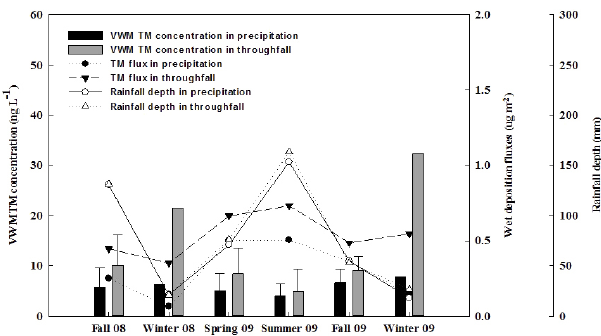
Figure 3. Seasonal variation in VWM TM concentration, rainfall depth, and TM flux in precipitation and